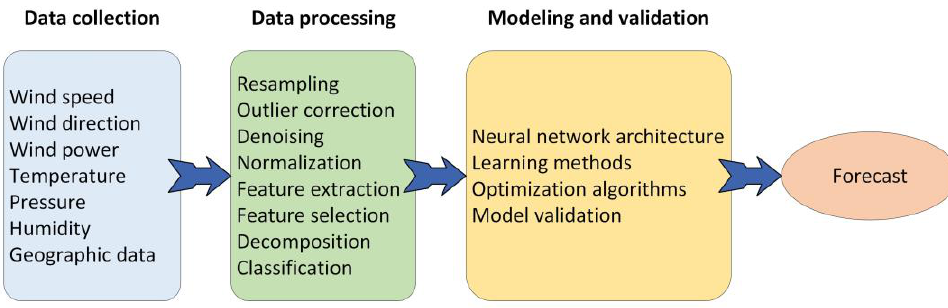
Figure 6. Framework of wind forecasting using artificial intelligent learning methods.